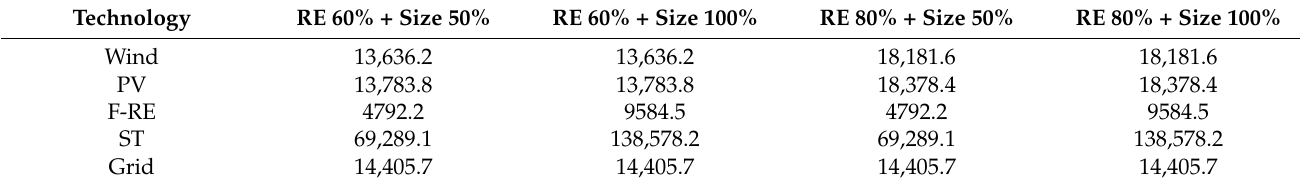
Table A21. Installed capacity in kW of the lowered RE production scenarios.